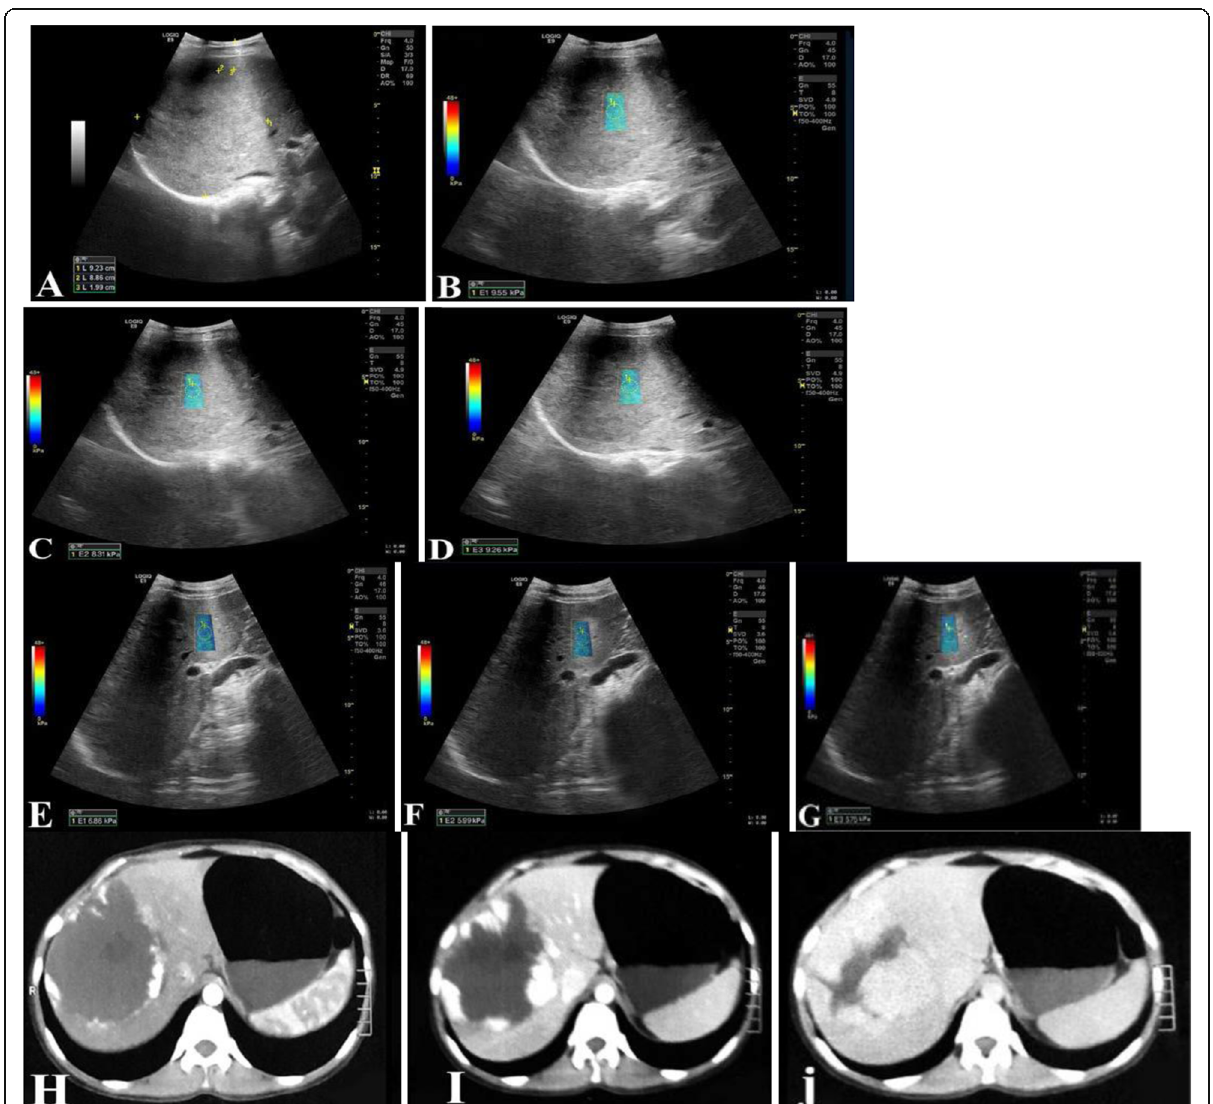
Fig. 1 Twenty-eight years old female patient presented with abdominal pain. Imaging findings: grey scale B-mode ultrasonography ( a ): normal sized liver with an ill-defined hyperechoic focal lesion seen in segment IV and VIII measuring 9.2 × 8.6 cm with 1.9 cm depth from the skin. Color- coded shear wave sono-elastography: the lesion showed faint blue color ( b , c , d ), while the liver parenchyma showed dark blue color ( e , f , g ). Shear wave sono-elastography stiffness value of the focal lesion: E1 = 9.55 kPa ( b ), E2 = 8.31 kPa ( c ), and E3 = 9.26 kPa ( d ). Calculated average stiffness value of the lesion = 9.04 kPa. Shear wave sono-elastography stiffness values of the parenchyma: E1 = 6.86 kPa ( e ), E2 = 5.99 kPa ( f ), E3 = 5.75 kPa ( g ).Calculated average stiffness value of the parenchyma = 6.2 kPa. (cid:129) Lesion/parenchyma stiffness ratio = 1.57. Axial contrast enhanced triphasic CT study (arterial ( h ), portal ( i ), and delayed ( j ) phases): average sized liver with a large well defined focal lesion seen in segment IV and VIII. It shows peripheral nodular enhancement in the arterial phase, progressive filling in the portal phase with persistent enhancement is seen in the delayed phase (close iris pattern). Diagnosis: